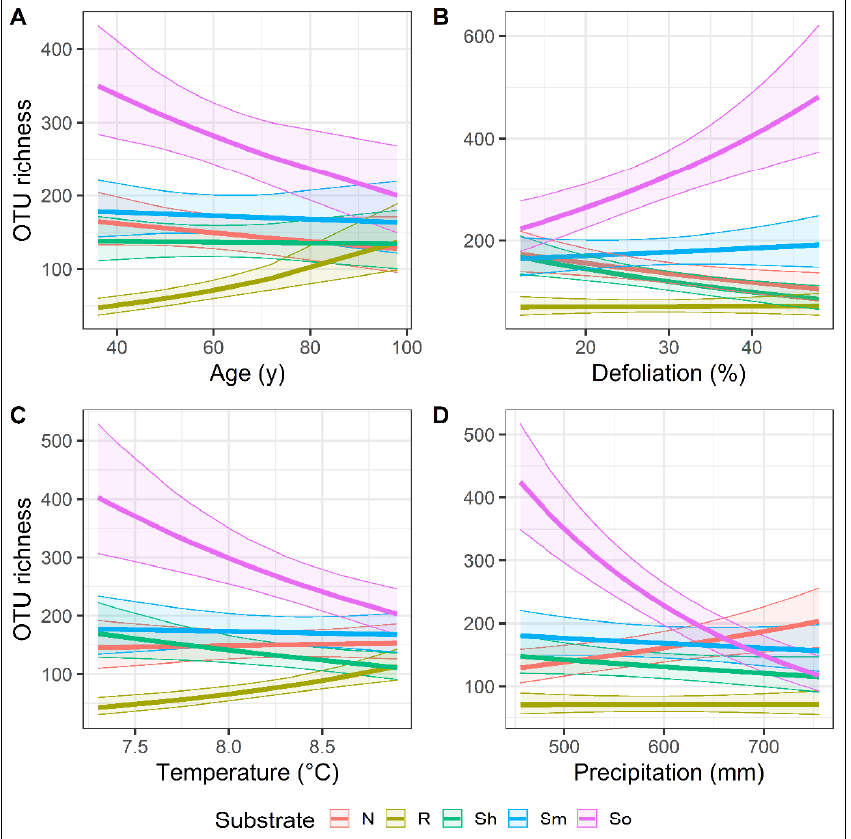
Figure 7. The relationship between the species richness of fungal OTUs in different substrates (needles, shoots, roots, mineral, and organic soil) of Pinus sylvestris and different stand ( A , B ) and climatic ( C , D ) parameters. The semitransparent field around each curve denotes the size of the deviation from the mean value.